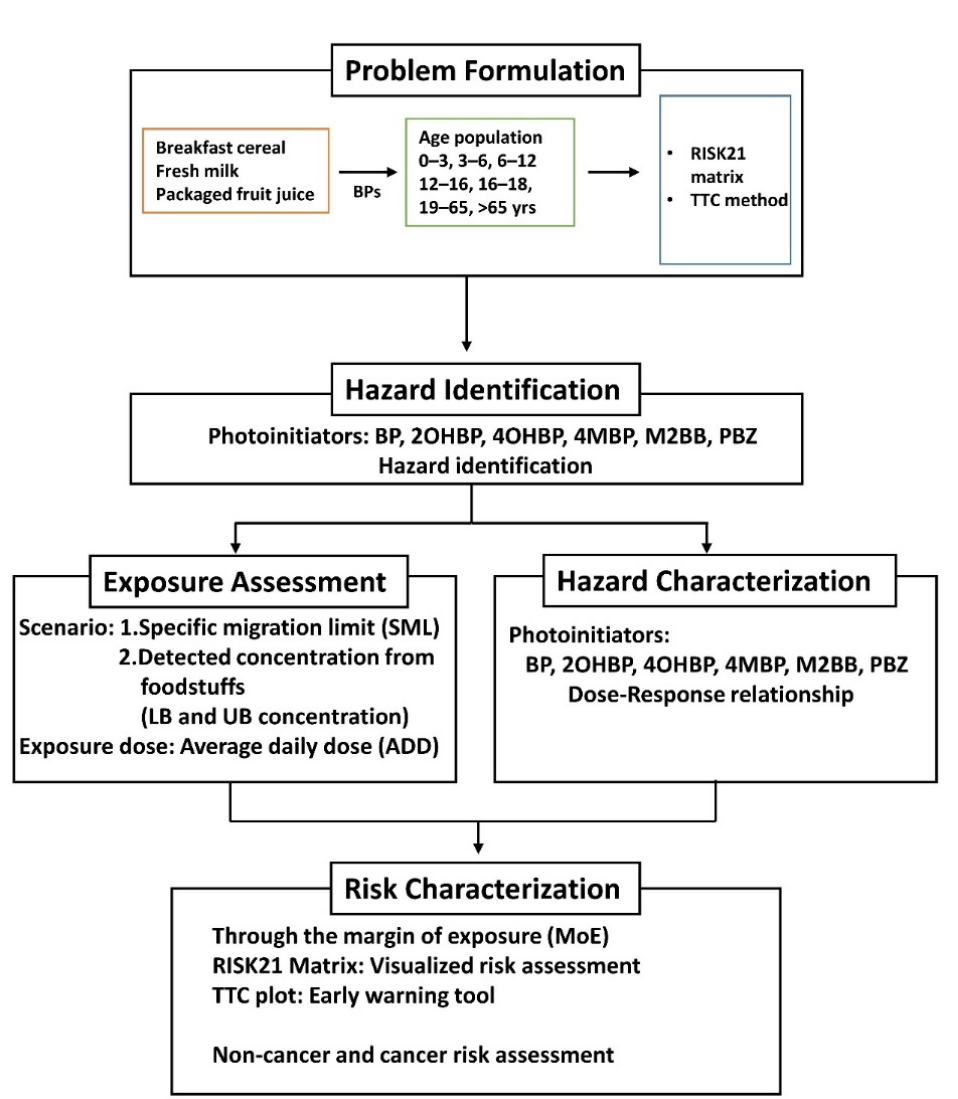
Figure 1. Steps of the risk assessment performed in this study. BP = benzophenone; 2-OHBP = 2-hydroxybenzophenone; 4-OHBP = 4-hydroxybenzophenone; 4-MBP = 4-methylbenzophenone; M2BB = methyl-2-benzoylbenzoate; PBZ = 4-phenylbenzophenone; TTC = threshold of toxicological concern; LB = lower bound; UB = upper bound.